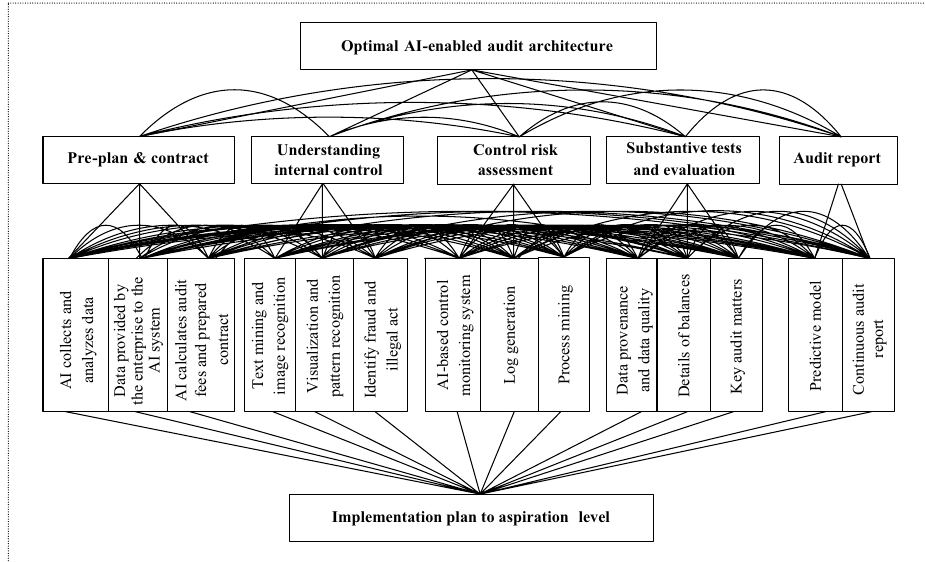
Figure 1. Analytic architecture of AI-enabled auditing mutual influence relationship